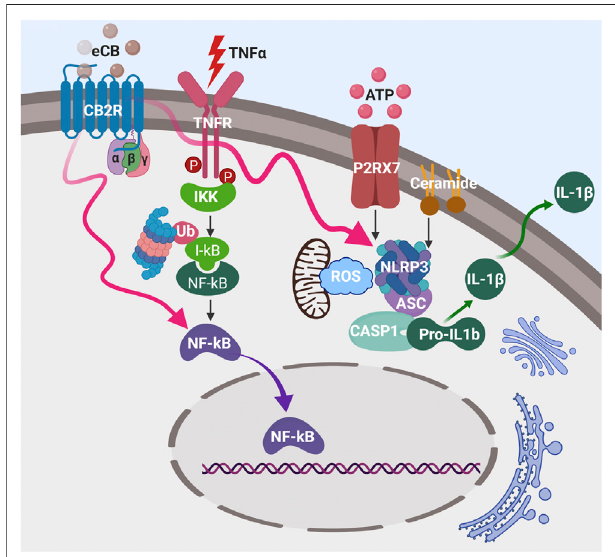
FIGURE 5 | Activation of plasma membrane CB2R pathway inhibits NLRP3in fl ammasomecomplexandNF κ Bactivation(redwavyarrows)during in fl ammationthatisinitiatedbyTNF α ,ATP,andceramide,therebyreducesIL- 1 β